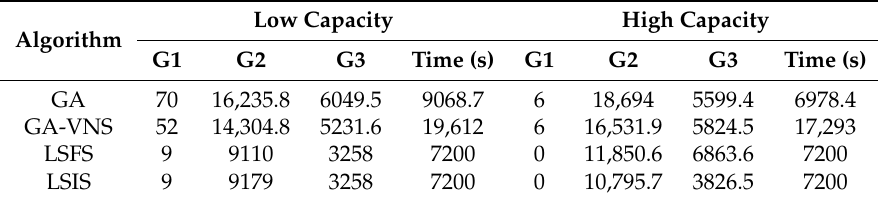
Table 6. Result of Case 6 (low capacity: 2000; high capacity: 4500).